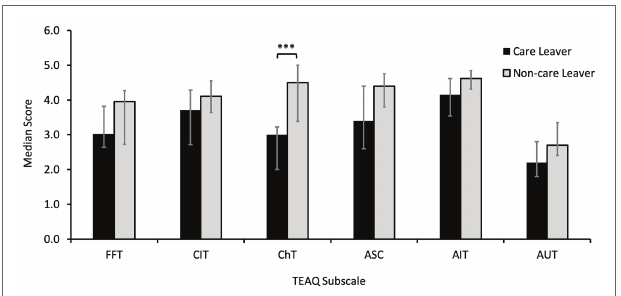
FIGURE 4 | Effect of location on vicarious touch pleasantness ratings. Mean pleasantness ratings ±95% confidence intervals are shown. There is a significant location by velocity interaction ( p < 0.01) which reflects the fact that ratings of touch on the back and on the palm show a different relationship between velocity and pleasantness than at the other three skin sites. On the palm ratings of touch pleasantness did not vary significantly by velocity (all ps > 0.5). On all three arm locations, 3 cm/s was rated significantly more pleasant than static or 30 cm/s touch (*** p < 0.0001, ** p < 0.001, * p < 0.01). While on the back ratings of 3 cm/s touch were only significantly higher than static (*** p < 0.0001) not 30 cm/s ( p = 0.26).